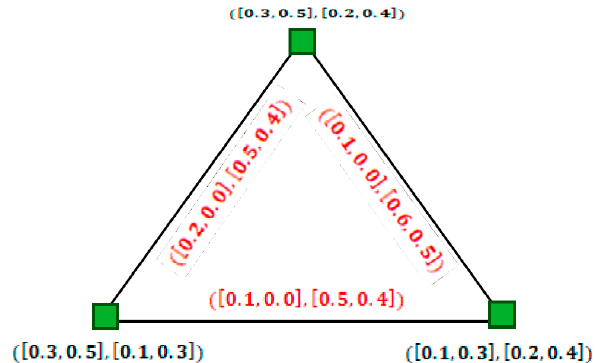
Figure 6. Interval-valued intuitionistic fuzzy graph ( IVIFG) obtained using Definition 6 with undefined intervals.